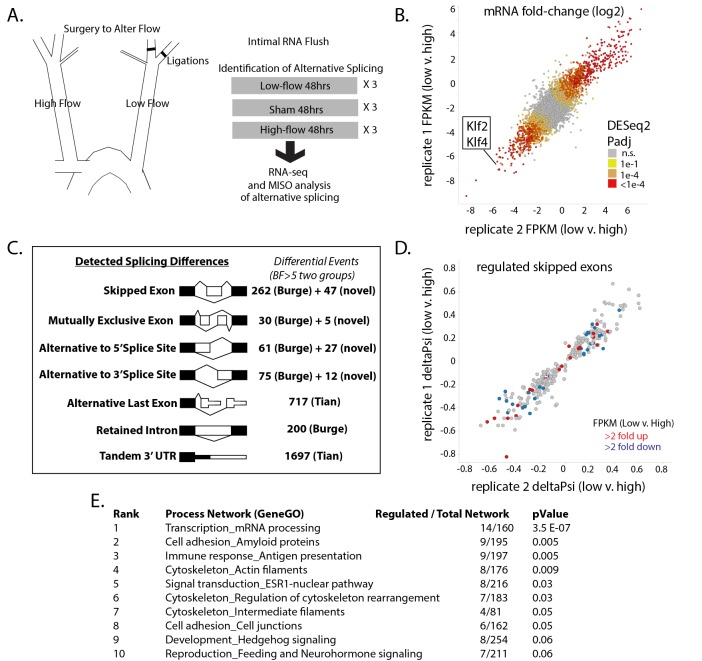
Exposure of the arterial endothelium to low and disturbed flow induces a program of alternative splicing.RNA from the arterial endothelium was isolated 48 hr after partial carotid ligation; from the low-flow side, the high-flow side, or sham-operated vessels. (A) Outline of splicing analysis. Three pools of mRNA from each condition were isolated by polyA and sequenced. (B) Plot showing the consistency of changes in gene expression in two independent biological comparisons of low-flow versus high-flow isolations. (C) Number of RNA splicing events of each category detected by MISO analysis as significantly different in two independent biological comparisons. Events were drawn from annotated databases (Burge, Tian) or from custom annotation of mapped splice junctions (novel). (D) Plot showing the changes in skipped-exon inclusion level (deltaPsi) between low-flow and high-flow isolations. The plot also indicates changes in transcription, highlighting exons in genes with a change in FPKM of more than 2-fold up or down. (E) Processes enriched in the genes with regulated skipped exons, relative to the entire set of genes expressed in the tissue with annotated skipped exons which were not significantly regulated. Padj = Adjusted P-value, BF = Bayes Factor; FPKM = Fragments Per Kilobase of transcript per Million mapped reads; CCDS = Consensus Coding DNA Sequence.10.7554/eLife.29494.008Figure 1—source data 1.Contains DESeq2 output from the analysis of biological triplicates of low flow and biological triplicates of high flow, where each biological triplicate contained 4–5 carotid flushes.DESeq2 was performed on samples following STAR alignment and sequencing counts as described in methods.10.7554/eLife.29494.009Figure 1—source data 2.Contains MISO from Tophat alignments of 80 bp reads, as described in the methods.See GEO file GSE101826 for annotation of samples.10.7554/eLife.29494.010Figure 1—source data 3.Contains bowtie alignments to eGFP or tdTomato for the indicated samples as described in the methods.